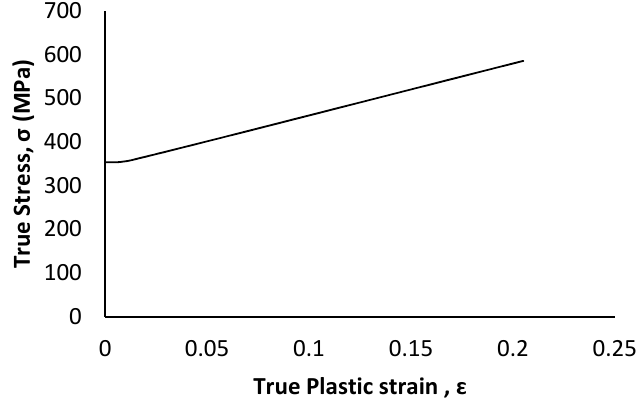
Figure 20. The true stress-true plastic strain curves of A36 steel [24].